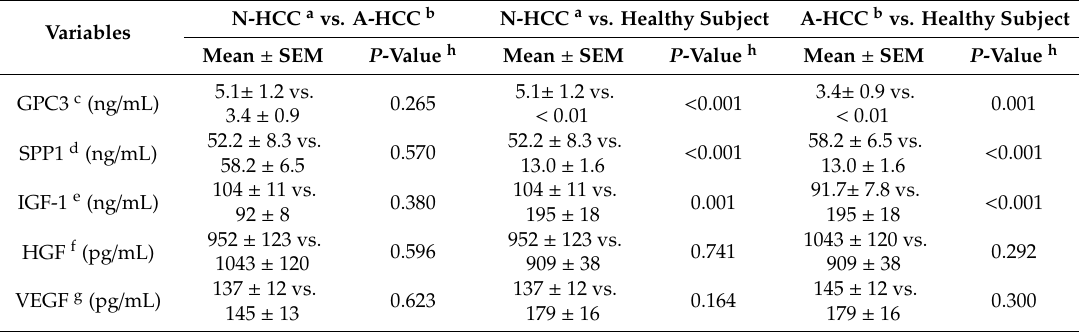
Table 5. Serum concentrations of various markers in patients with HCC ( n =